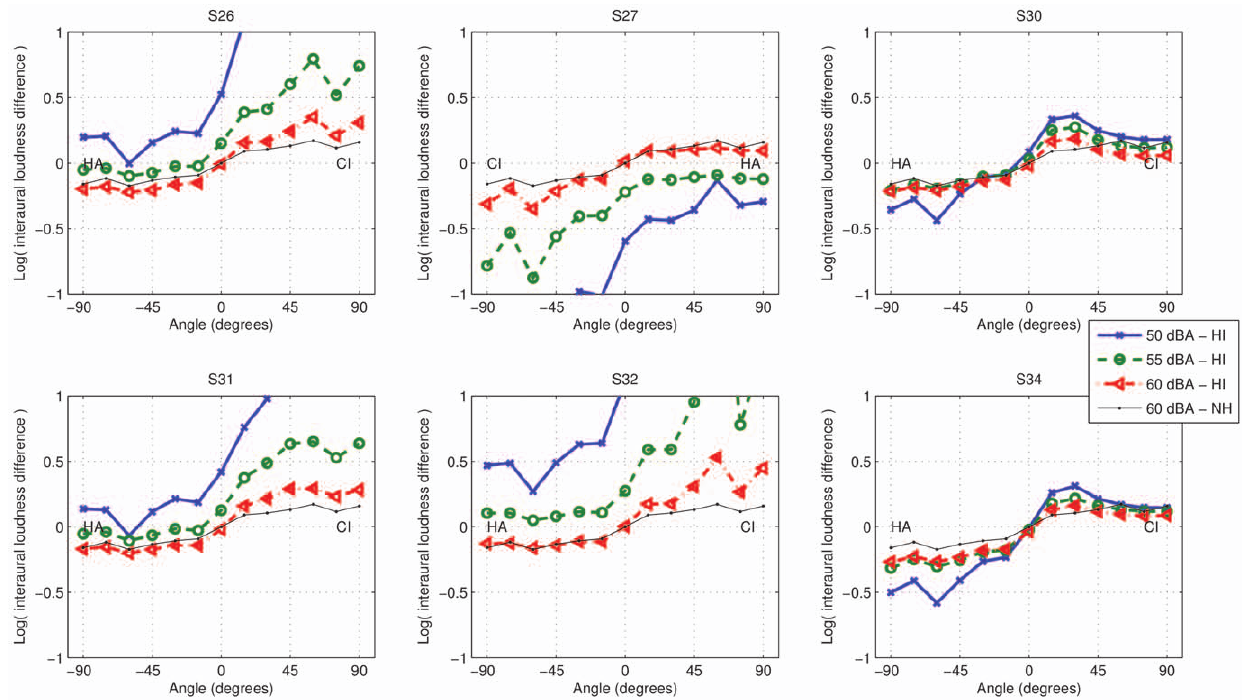
Figure 8. Interaural loudness differences for a speech-weighted click train, predicted according to the hearing loss of each participant. The thick coloured lines indicate ILoDs at the output of ACE for different input levels. The thin black line shows the ILoD for a normal- hearing listener for a stimulus at 60 dB A. The thick lines show the loudness after CI and HA processing, taking into account hearing impairment.